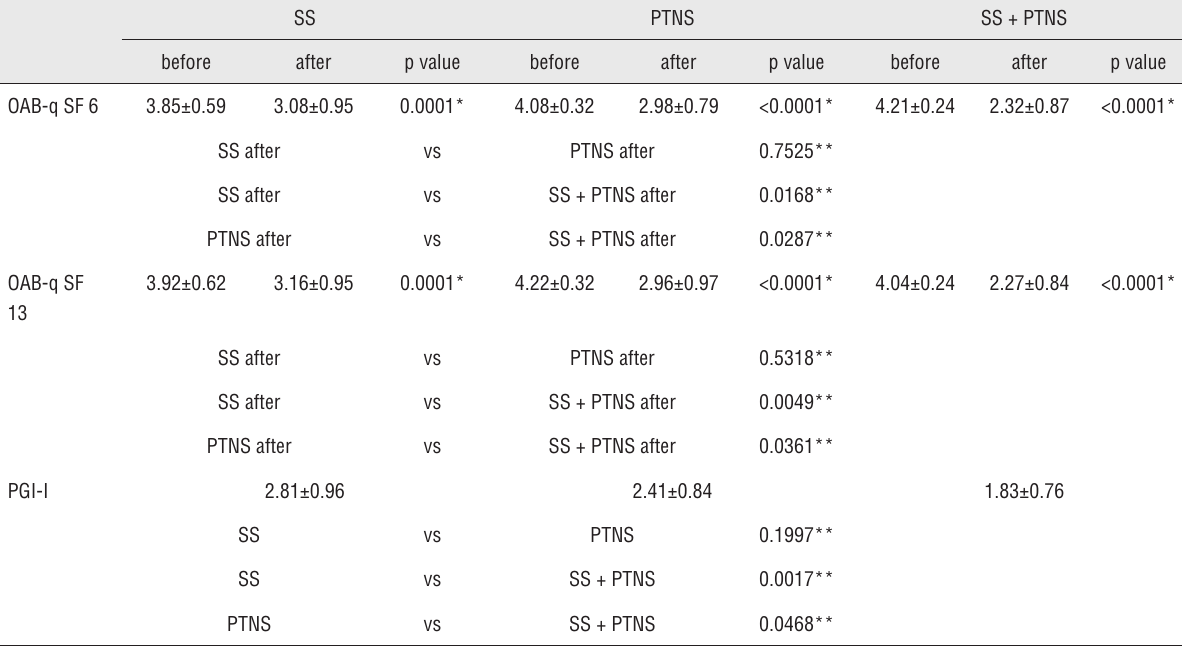
Table 2 - Improvements assessed with quality of Life questionnaire (6 and 13 items) (OAB-q sF 6 and 13) and Patient Global Impression of Improvement questionnaire (PGI-I) at the end of